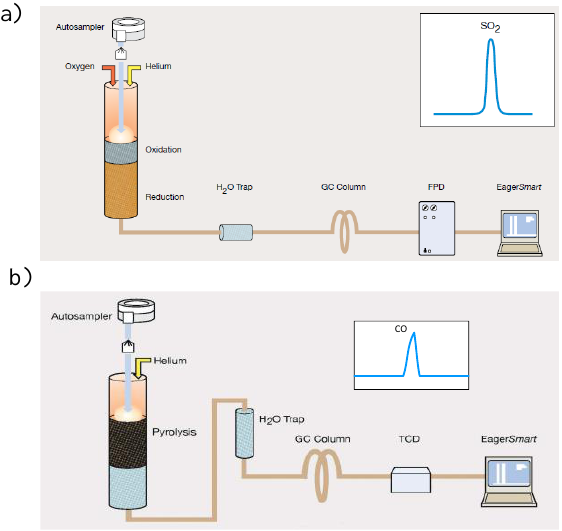
Fig. 2. Schematic diagram of the gas chromatography in the scope of determining the mass fractions, respectively: a) sulfur S, b) oxygen O, in a liquid fuel [19]